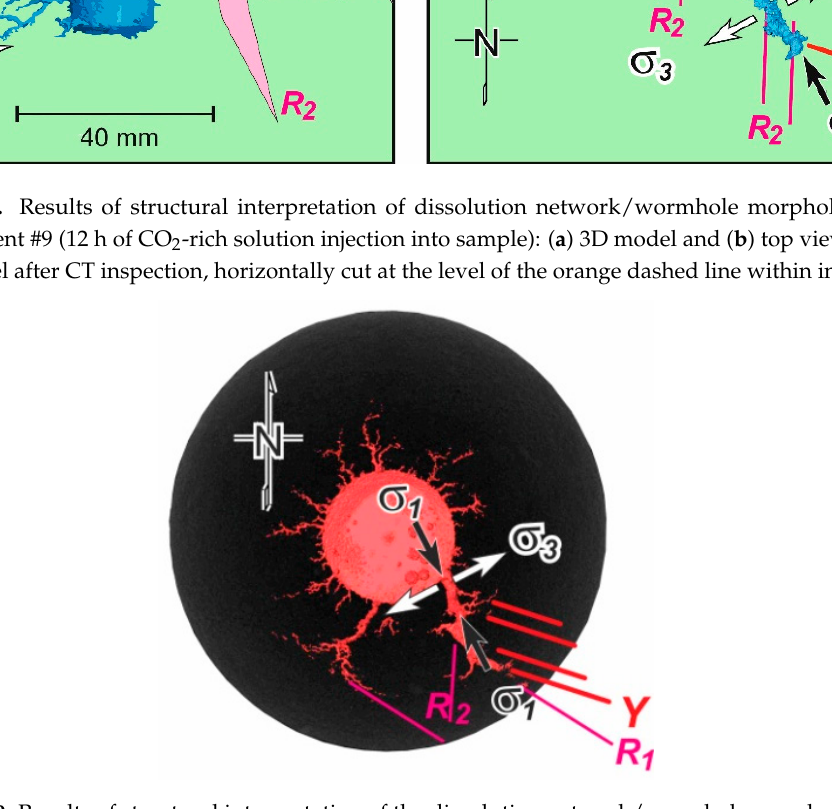
Figure 9. Results of structural interpretation of dissolution network/wormhole morphology for experiment #9 (12 h of CO 2 -rich solution injection into sample): ( a ) 3D model and ( b ) top view of the 3D model after CT inspection, horizontally cut at the level of the orange dashed line within inset ( a ).